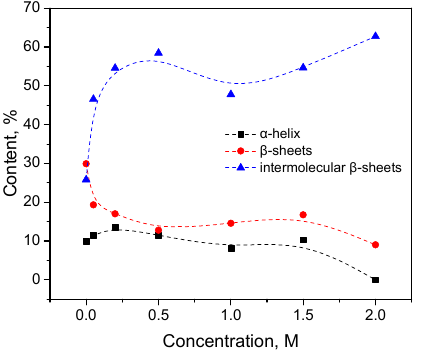
Figure 14. Change in the secondary structure of trypsin in the interaction with potassium thiocyanate at 80 °C.